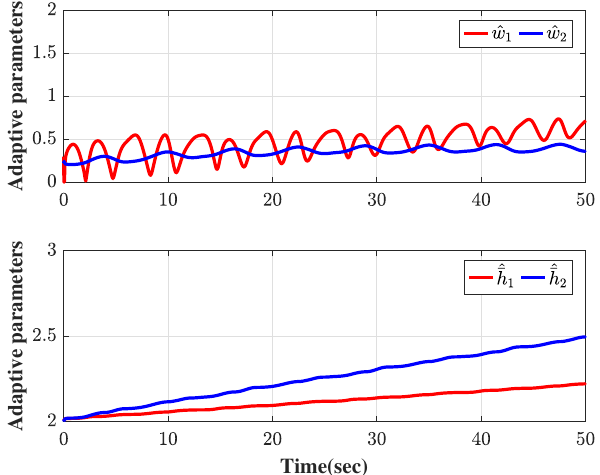
Figure 2. Evolution of adaptive parameters.